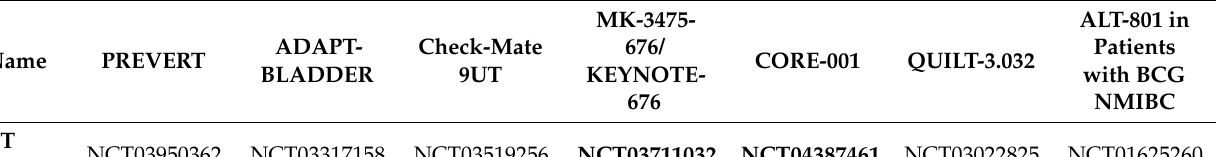
Table 4. Ongoing/upcoming clinical trials testing immunotherapy in BCG refractory BC